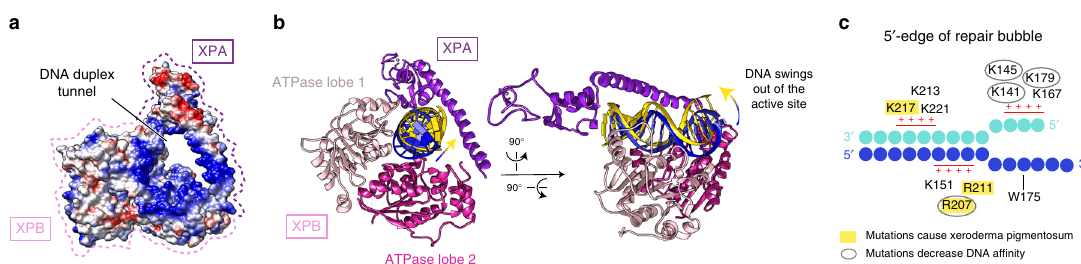
Fig. 3 XPA – DNA interactions. a DNA duplex tunnel formed by XPA and XPB. Blue, white, and red color indicates positive, neutral, and negative electrostatic surface potential, respectively. Created with UCSF Chimera. b Two positions of DNA in the tunnel. Tightly bound DNA is in blue, dissociated DNA in yellow, ATPase lobe 1 of XPB in pink, ATPase lobe 2 in hot pink, and XPA in purple. c Electrostatic interactions between XPA and the DNA junction. DNA nucleotides are indicated as circles. Patches of positively charged residues in proximity to the DNA backbone are indicated. Residues that are mutated in Xeroderma pigmentosum are highlighted in yellow 16 . Mutation of encircled residues decreases DNA af fi nity